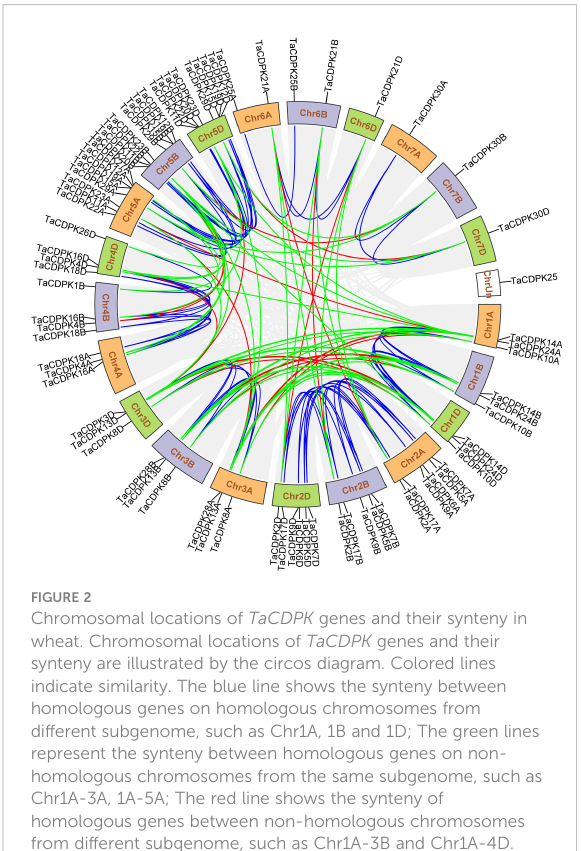
FIGURE 2 Chromosomal locations of TaCDPK genes and their synteny in wheat. Chromosomal locations of TaCDPK genes and their synteny are illustrated by the circos diagram. Colored lines indicate similarity. The blue line shows the synteny between homologous genes on homologous chromosomes from different subgenome, such as Chr1A, 1B and 1D; The green lines represent the synteny between homologous genes on non- homologous chromosomes from the same subgenome, such as Chr1A-3A, 1A-5A; The red line shows the synteny of homologous genes between non-homologous chromosomes from different subgenome, such as Chr1A-3B and